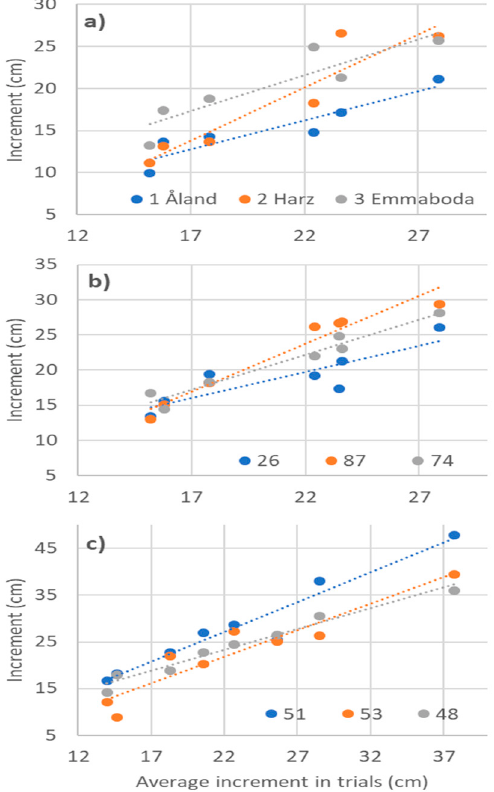
Figure 3. Estimated regressions lines for the genetic entries’ height increment as a function of the average increment of the trials shown for ( a ) three selected provenances (sites 1–7), ( b ) families (sites 1–7), and ( c ) clones within family 83 (sites